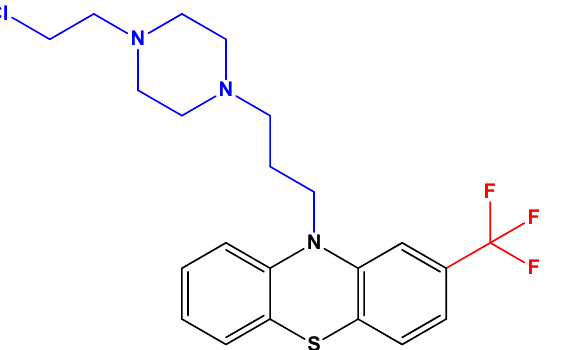
Figure 4. Chemical structure of fluphenazine mustard, an analog of fluphenazine. The structure was obtained using ChemDraw software (version 12.0, PerkinElmer, Inc., Waltham, MA, USA). Adapted from